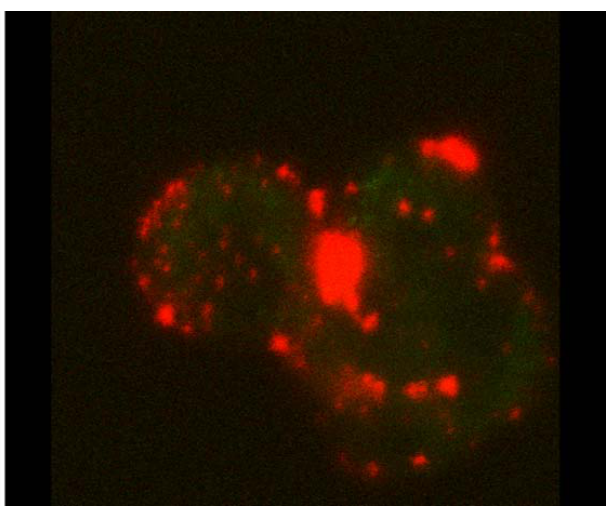
FIGURE 6 . Example of the in vitro use of fluorescent QDots conjugated to detect the cell-surface receptor (tumor-associated antigen-72) overexpressed in LS174T human adenocarcinoma cells. Bright red fluorescence from the QDot probes is observed on the cell surface of the colon tumor cells (which also emit a weak green autofluorescence), indicating specific targeting (458-nm excitation; green channel = 500–530 nm; red channel = 650–710 nm).